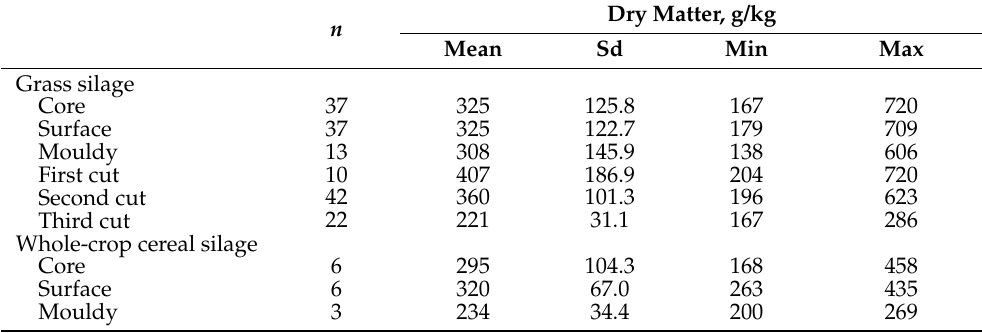
Table 2. Number of samples and dry matter concentrations of grass and whole-crop cereal silage samples. Results of different cuts include both surface and core samples, but not mouldy